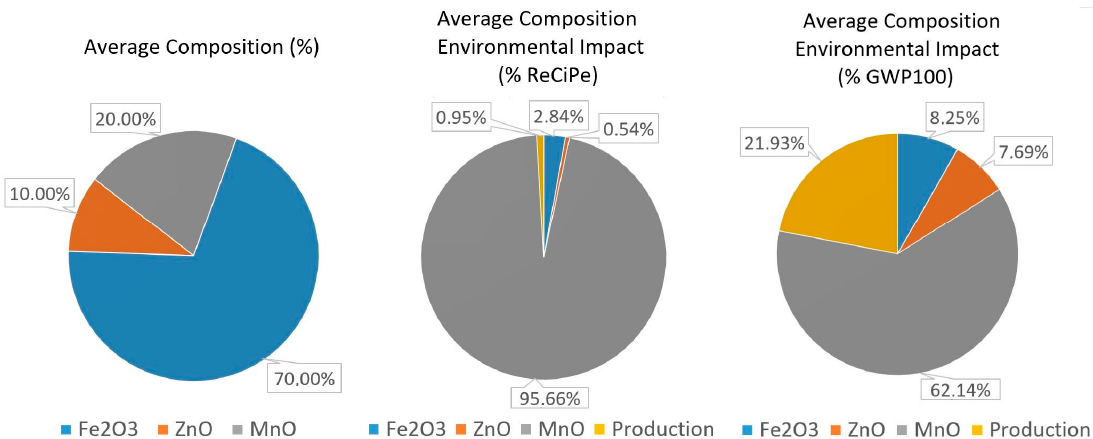
Figure 6. MnZn soft ferrite with average composition environmental impact in the ReCiPe and Carbon Footprint methodologies.